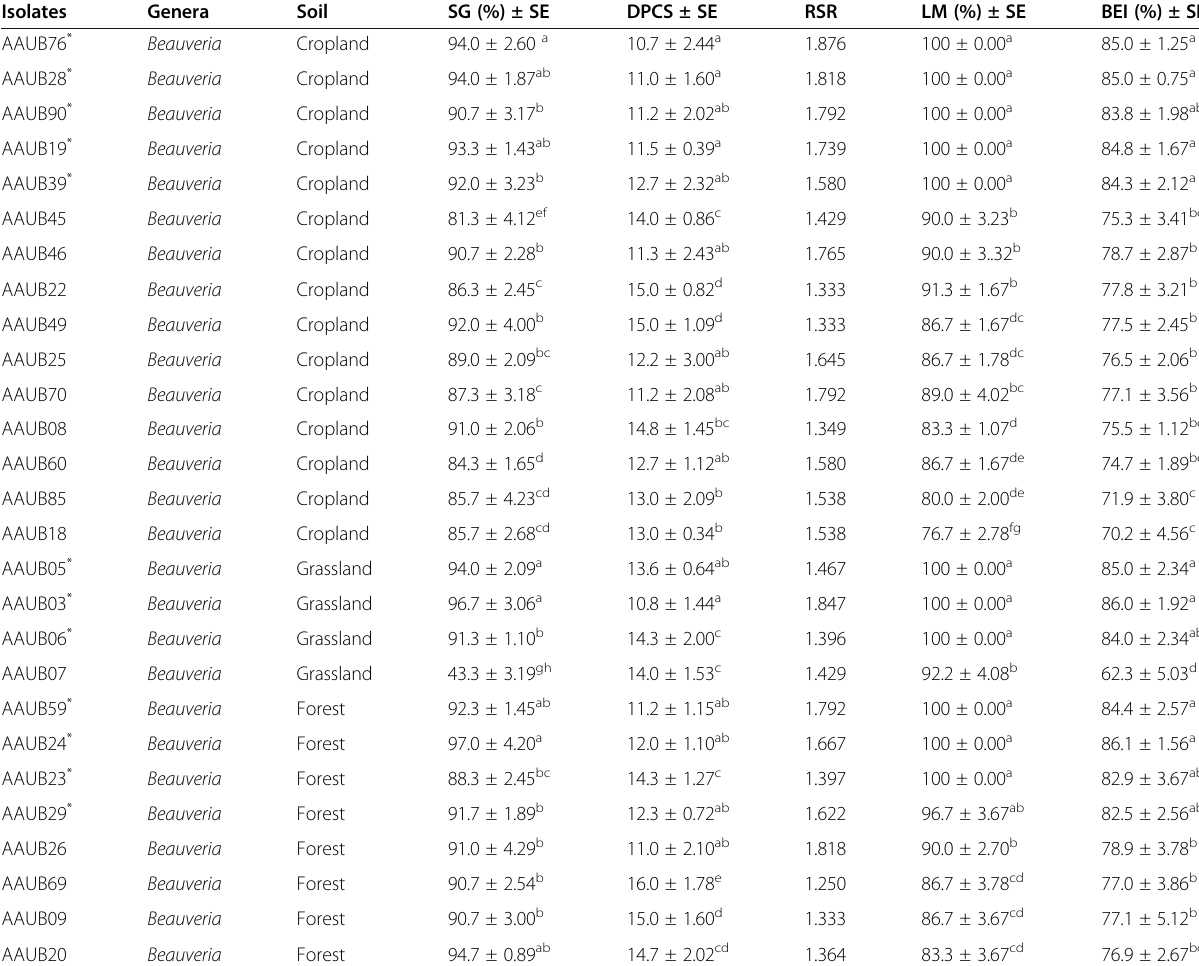
Table 1 Percentage of spore germination, culture sporulation in 20 days, larval mortality of Galleria mellonella at 1 × 10 7 spores·ml -1 concentration within 10 days, and biological efficacy index of the isolates Isolates